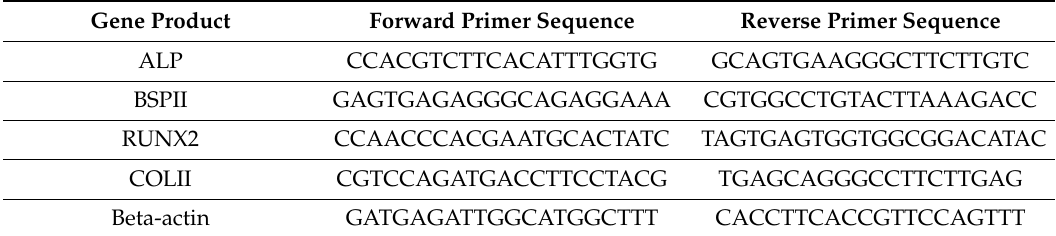
Table 2. List of primers